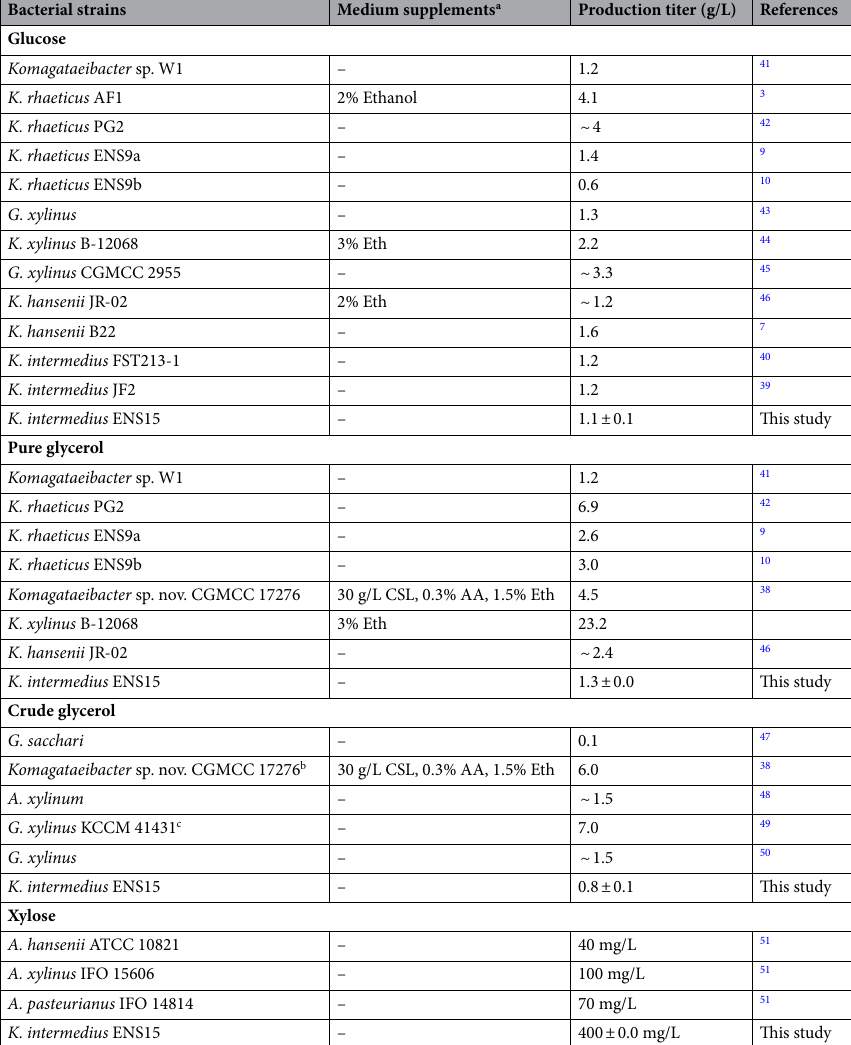
Table 1. BC production metrics from Komagataeibacter spp. grown statically in growth medium containing glucose, pure glycerol, crude glycerol, and xylose reported in literature. CSL corn steep liquor, AA acetic